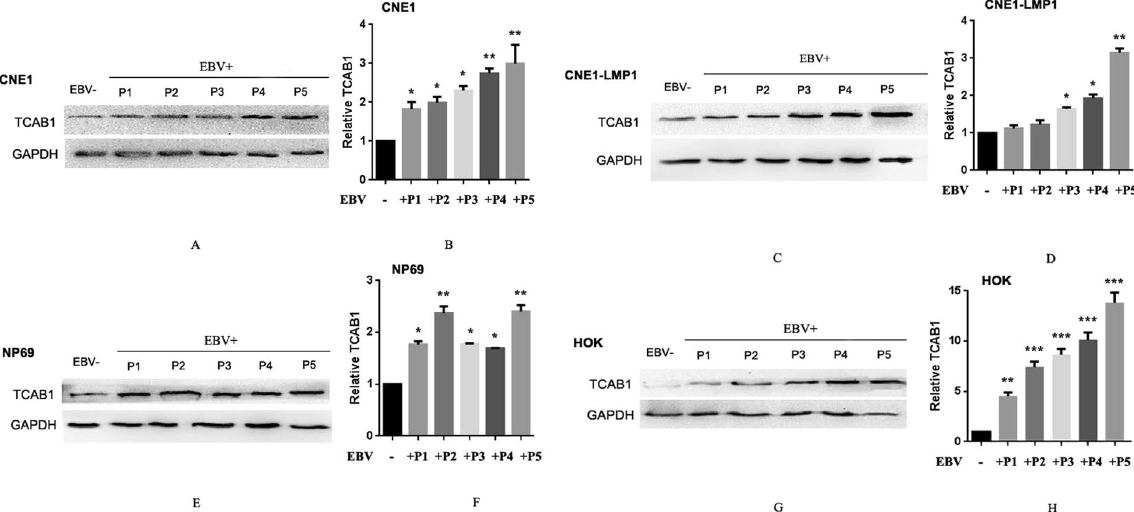
Figure 2. The expression level of TCAB1 is up-regulated by EBV in cell lines. ( A , C , E , G ) Protein level of TCAB1 in the first to fifth passages of CNE1, CNE1-LMP1, NP69 and HOK cells after EBV infection compared to EBV-negative cells. ( B , D , F , H ) Quantitative results of TCAB1 protein levels relative to GAPDH in each cell line. EBV + , EBV-positive; EBV − , EBV-negative. P1-5: passages 1–5 after EBV infection. The error bars represent the mean ± SD values. The statistical analysis was performed using Student’s t test ( * P < 0.05, ** P < 0.01, *** P < 0.001).